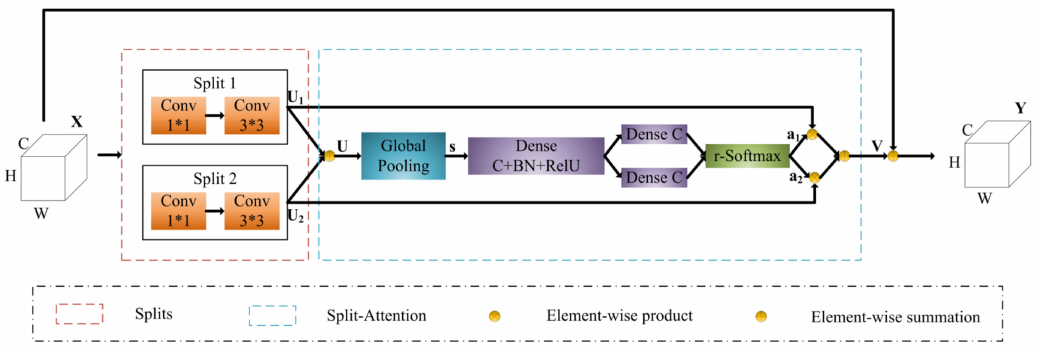
Figure 4. Split-Attention